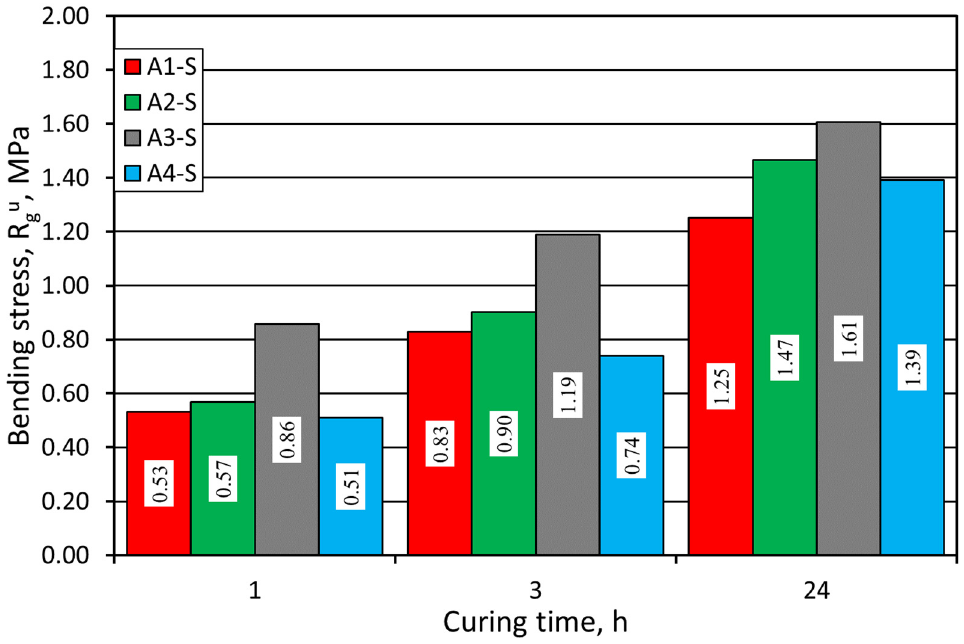
Figure 3. Molding sand R u g bending stress test carried out on SIBELCO (S) grain matrix.